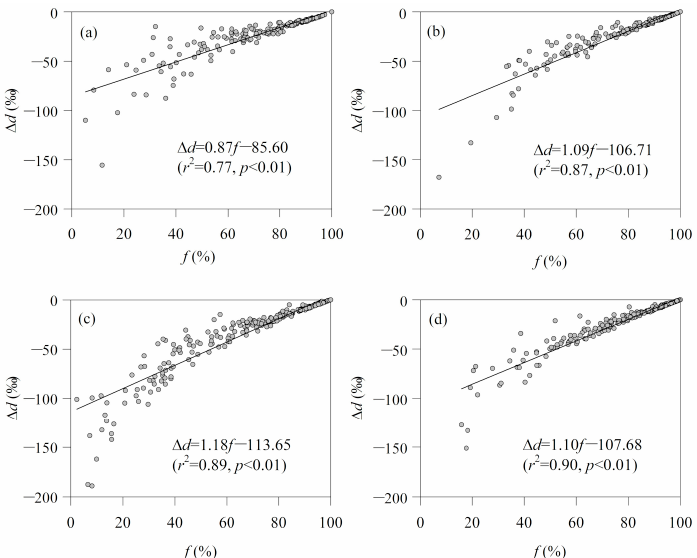
Figure 11. Relationships between f and Δ d in precipitation for each site ( a ). Anning, ( b ). Yuzhong, ( c ). Gaolan, ( d ). Yongdeng.